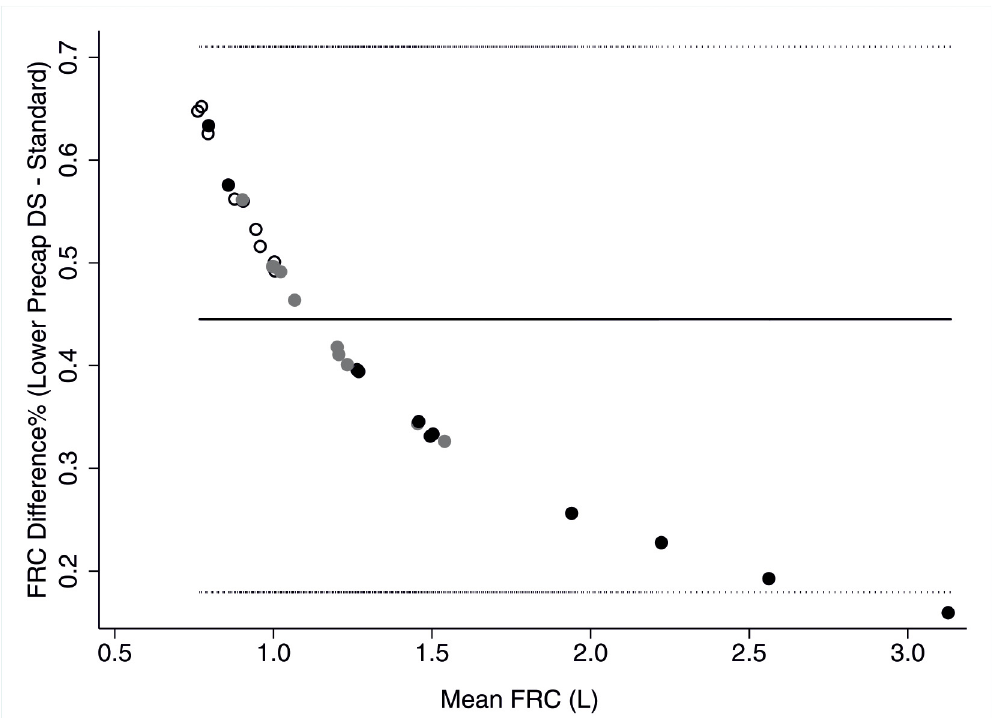
Fig 3. Non-linear FRC measurement bias due to decreased pre-capillary dead space. Bland Altmann plot of functional residual capacity (FRC) determined at lower pre-capillary dead space setting (19 mL instead of 24 mL) minus baseline FRC versus mean of both FRC. Black circles represent children with CF, grey circles former preterm and open circles healthy children. Solid line represent mean difference (0.45%), dotted lines represent upper (0.71%) and lower (0.18%) limits of agreement.